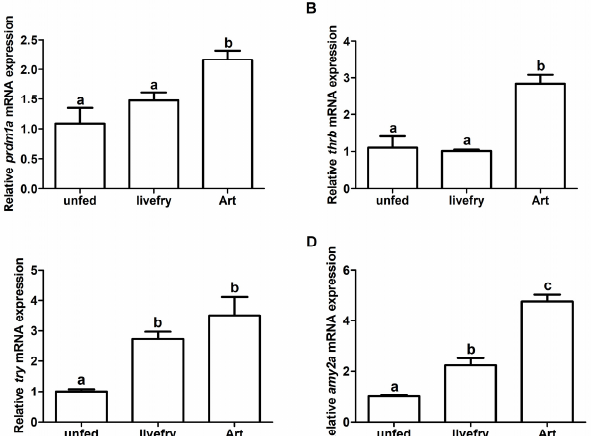
Figure 5. Experimental validation of DEGs by RT-qPCR. ( A ). PR domain zinc finger protein 1a ( prdm1a ); ( B ). thyroid hormone receptor beta ( thrb ); ( C ). pancreatic trypsin ( try ); ( D ). pancreatic alpha-amylase-like ( amy2a ). Data are represented as mean ± S.E.M. ( n = 6). Data with different letters above the bars indicated significant differences ( p <